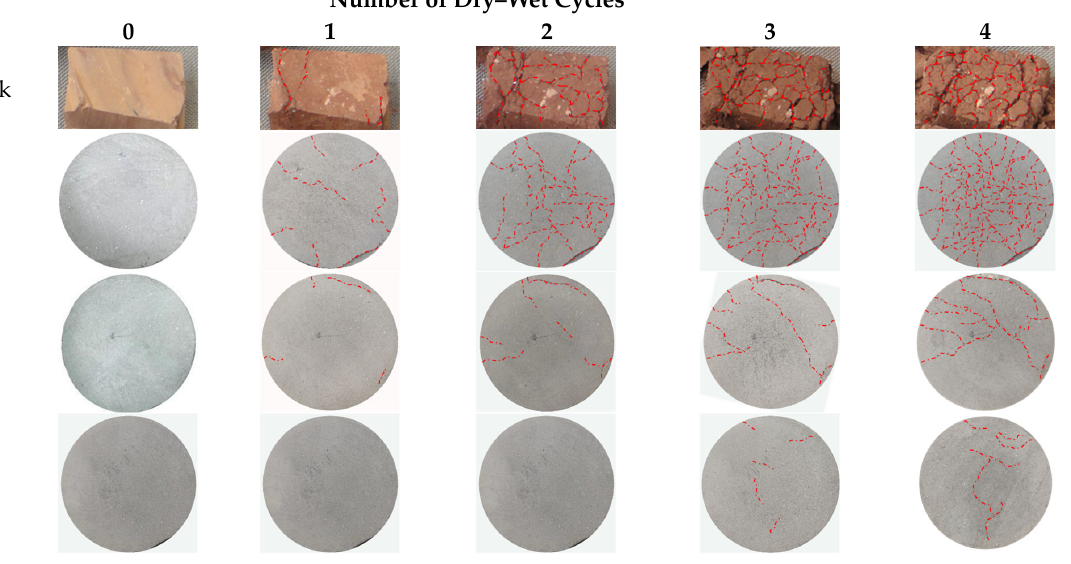
Figure 5. Development of cracks on the surface of similar material specimens by water immersion and